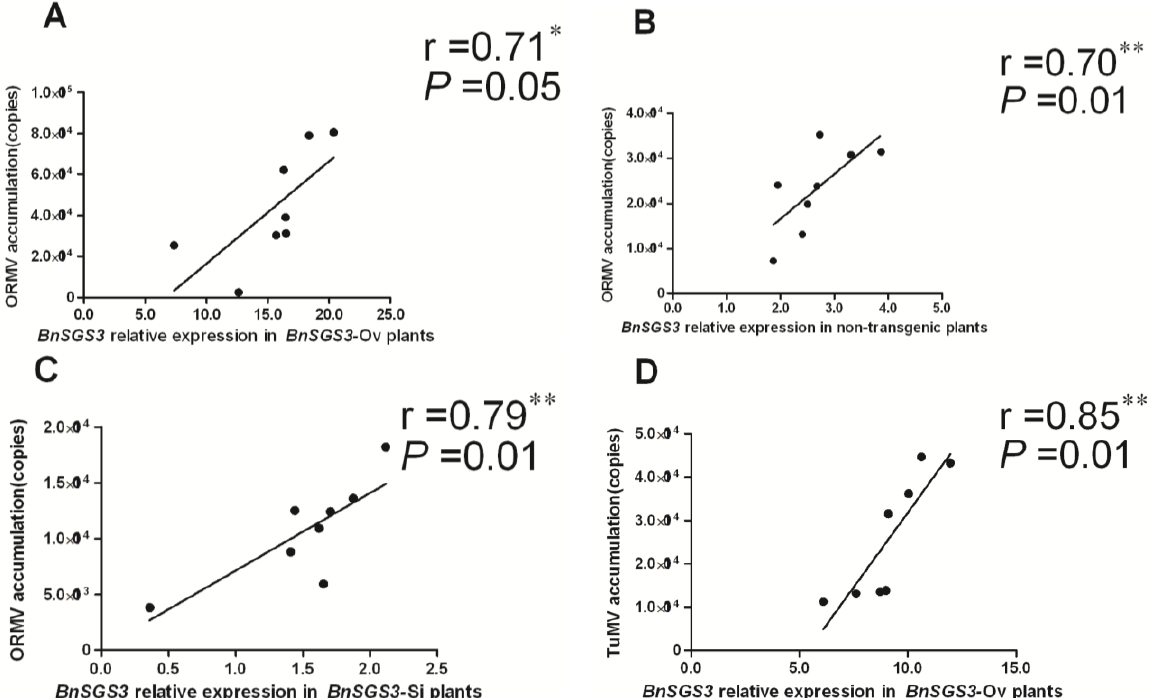
Figure 6. Cont Figure 6. Cont. Figure 6. Cont.